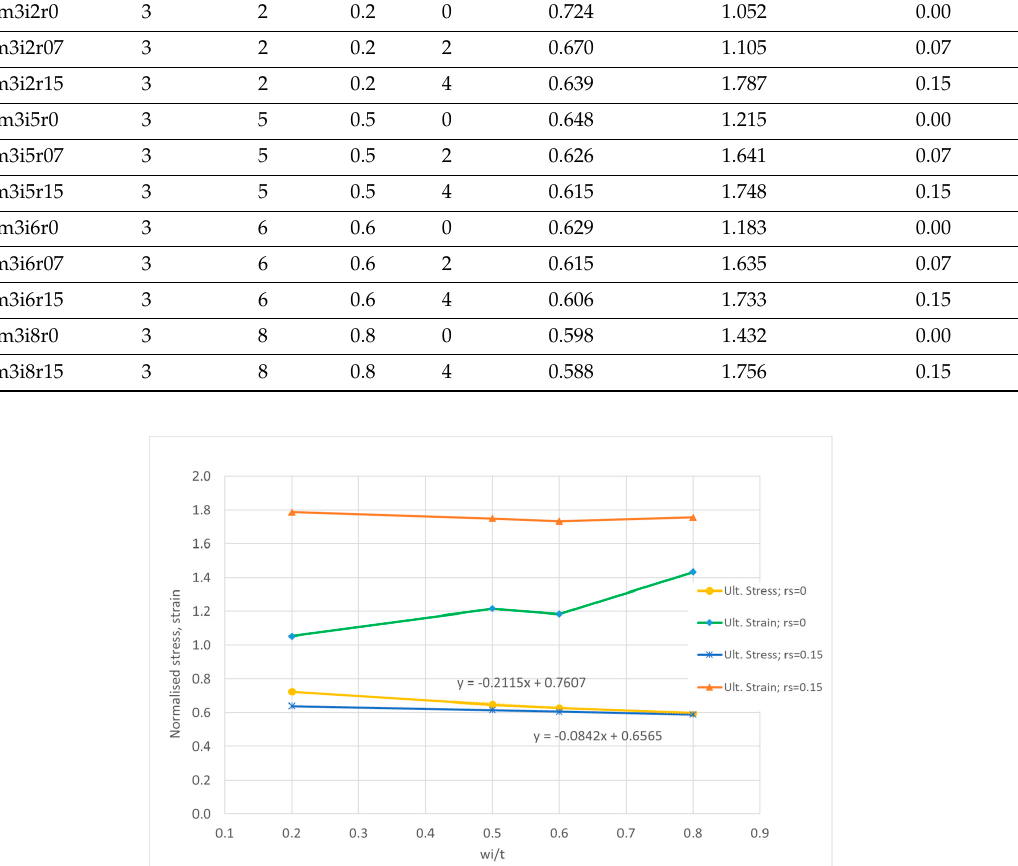
Figure 11. Variation of ultimate strength and corresponding normalized strain for plates with t = 10 mm, m = 3 and no residual stresses.